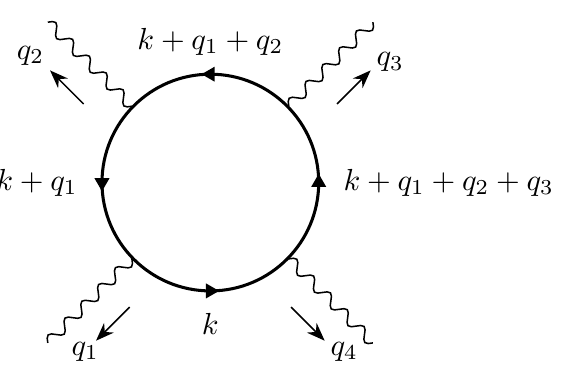
Figure 10. The four-photon subdiagram with a fermion loop, which has unphysical UV divergences diagram by